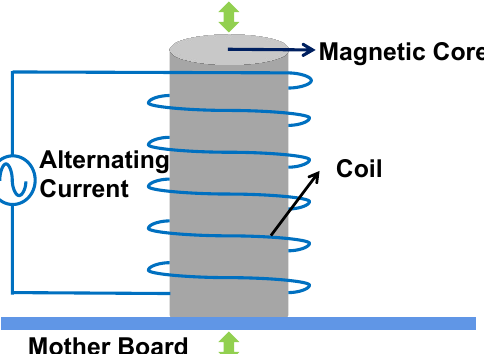
Figure 6. Magnetostriction of magnetic core under influence of alternating current.